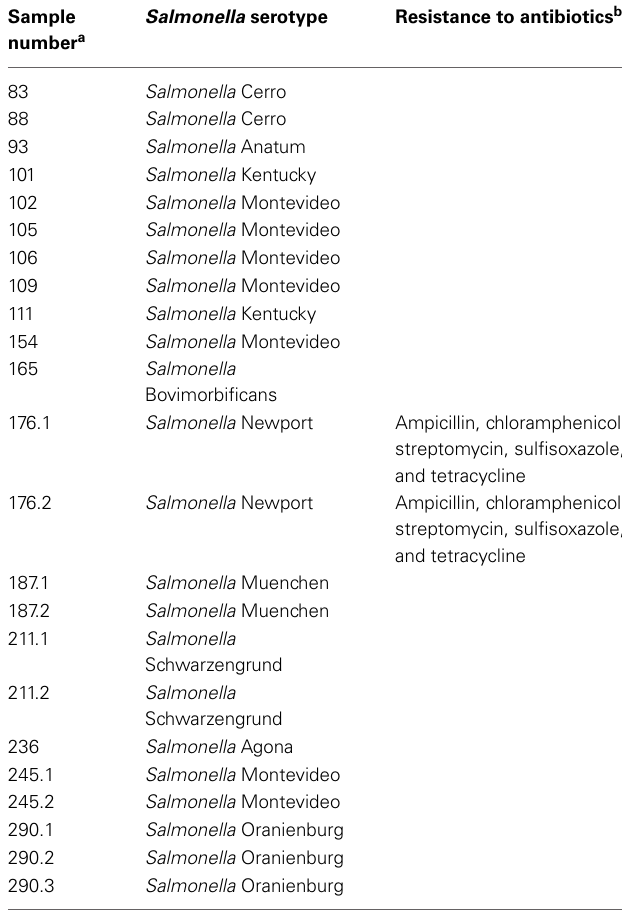
Table 4 . The Salmonella serotypes included, S . Cerro, S .